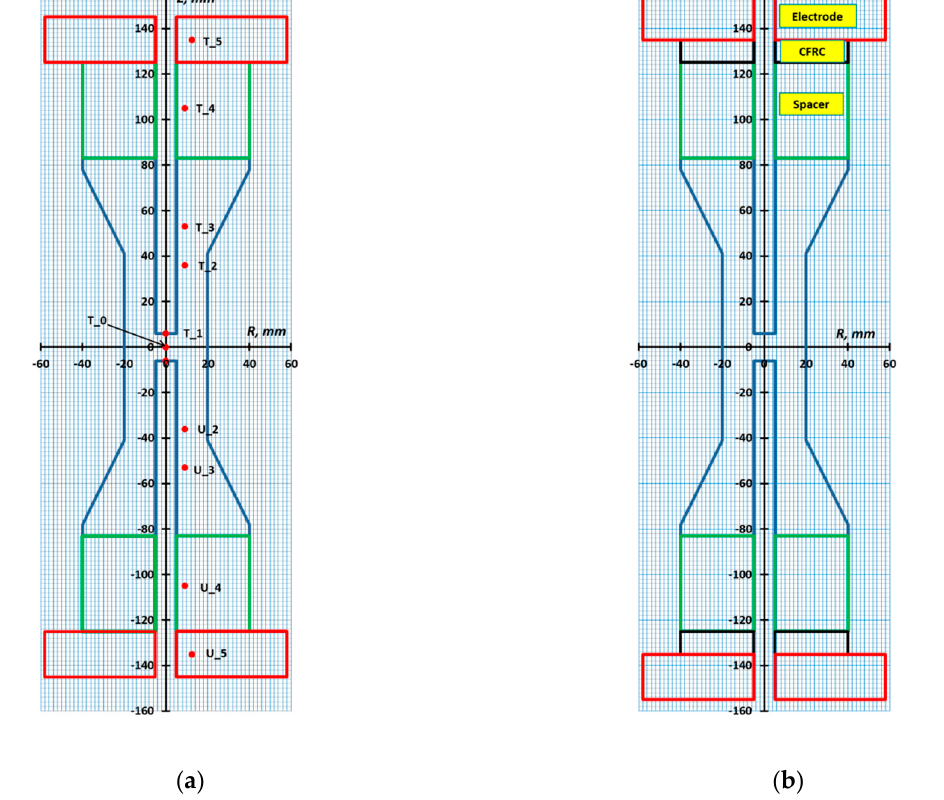
Figure 1. Sketch of used field-assisted sintering technique/spark plasma sintering (FAST/SPS) setups: ( a ) regular setup without CFRC plates and ( b ) setup with CFRC plates. The locations of temperature and voltage test points are indicated by red marker.